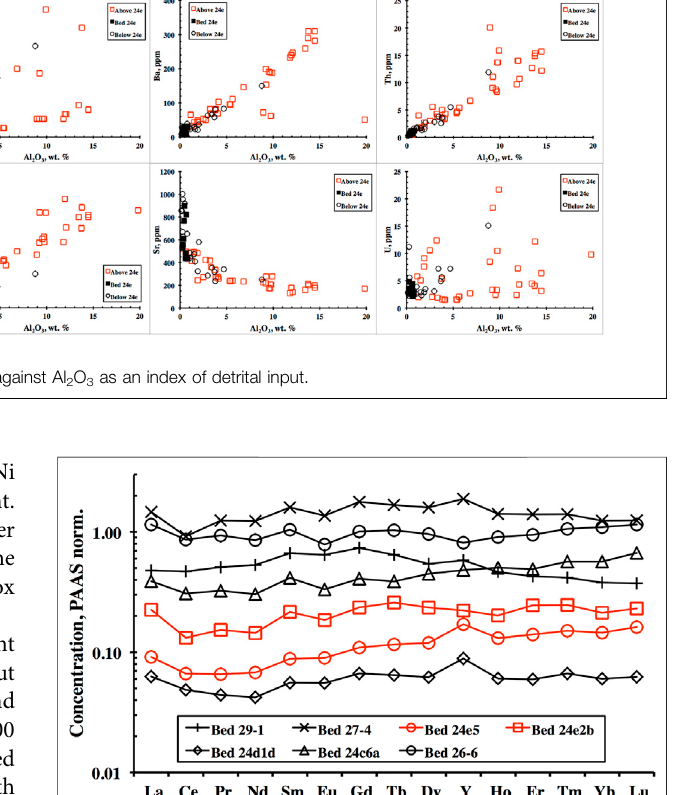
Frontiers in Earth Science |